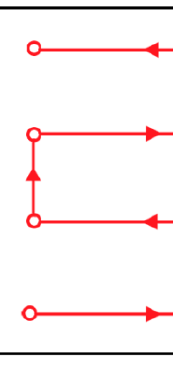
Figure 7. Cutting path.